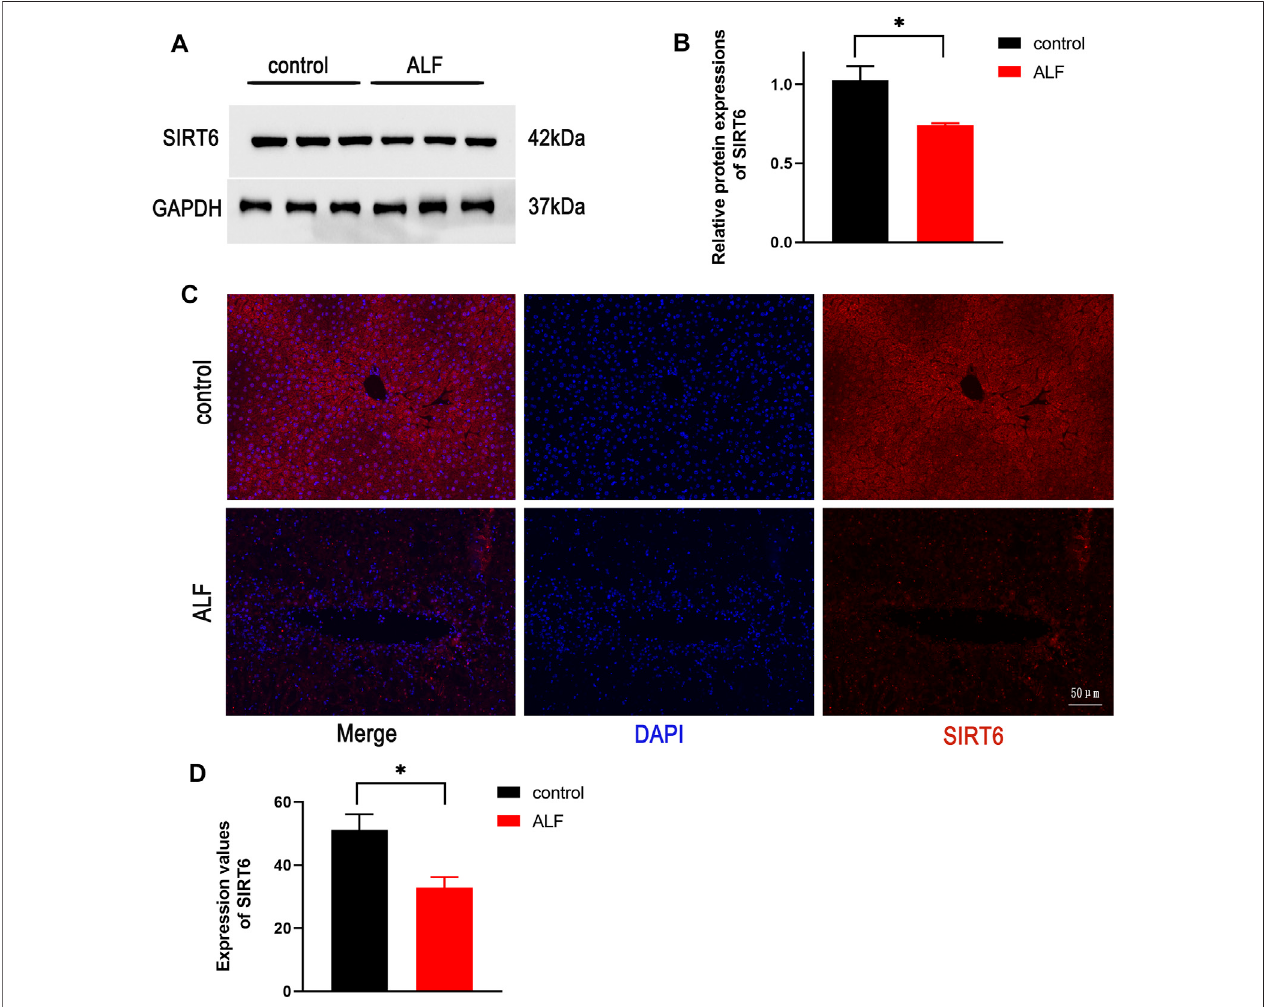
FIGURE 1 | SIRT6 expression of liver tissue in the TAA-induced ALF model in mice. (A) Western blot analysis of SIRT6 levels in TAA-induced ALF mice. (B) Densitometric analysis of SIRT6. (C) Immuno fl uorescence staining of SIRT6 in liver tissue. (D) Quantitative value of fl uorescence. * p < 0.05, compared with the control group. n = 5 per group. Data are represented as mean ±